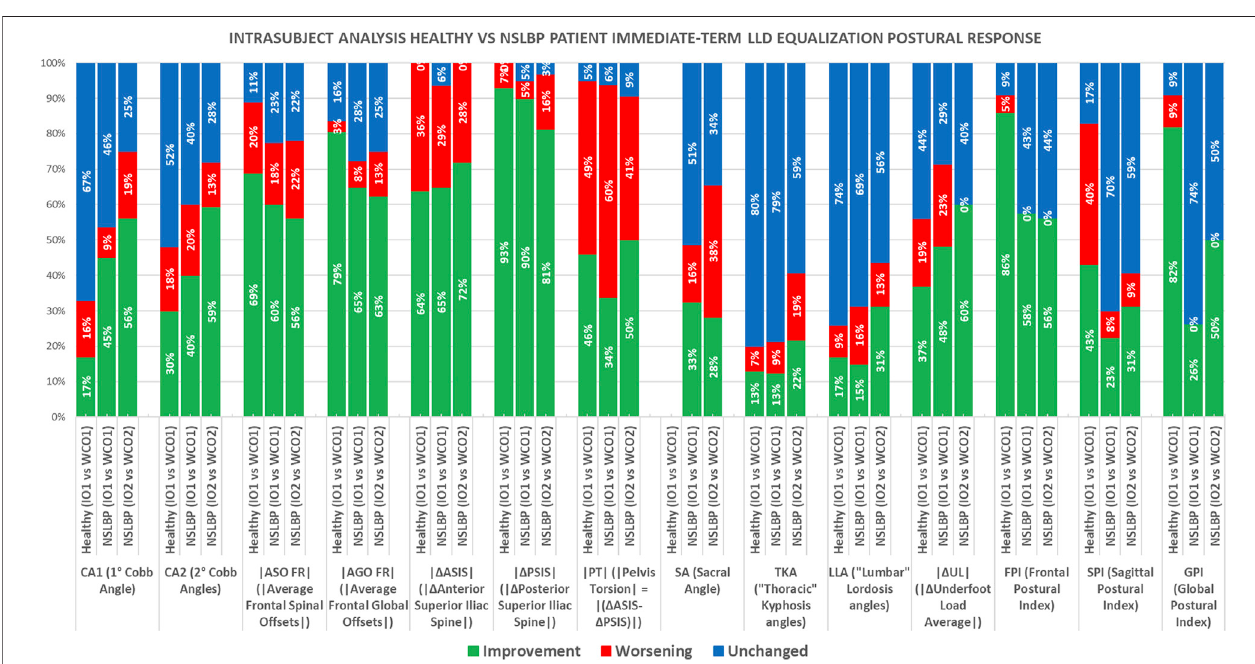
Frontiers in Bioengineering and Biotechnology |